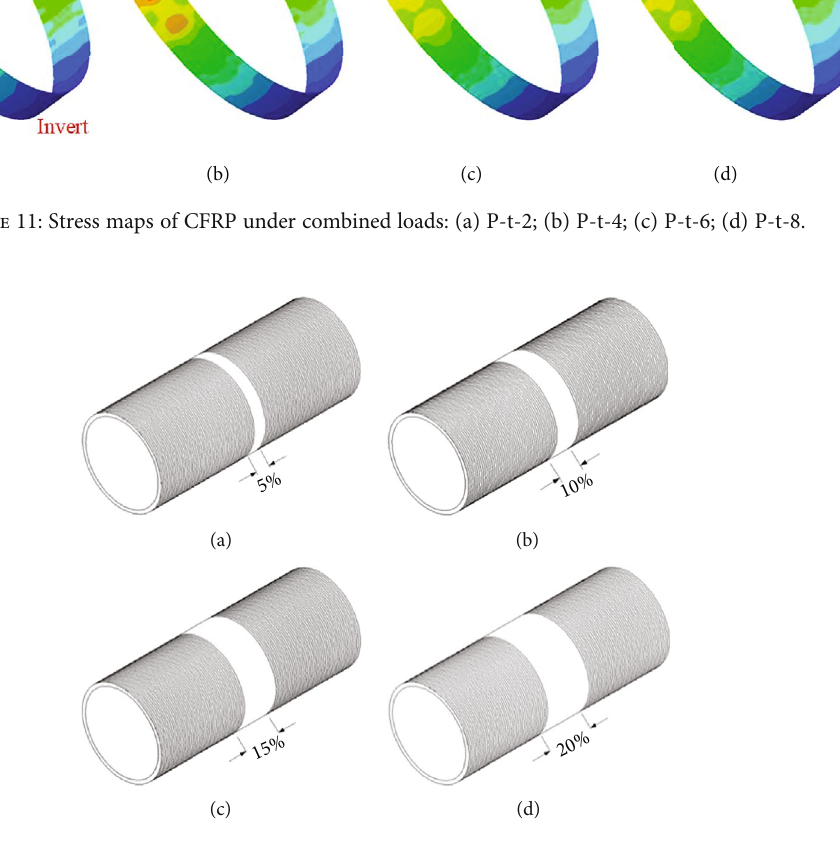
Figure 12: The di ff erent models: (a) P-r-5; (b) P-r-10; (c) P-r-15; (d) P-r-20. (P is pipe, r is rate, and the number is the value of the wire breakage rate).